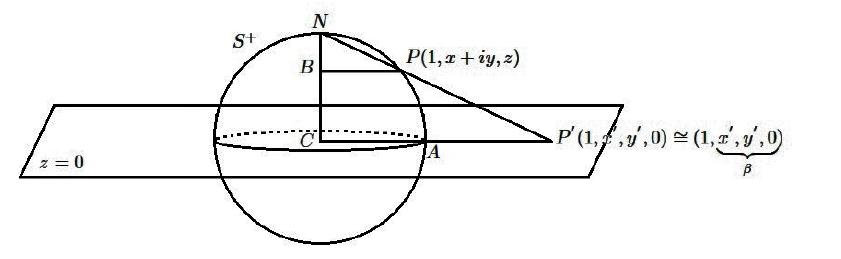
Figure 2. The simple construction of Equation